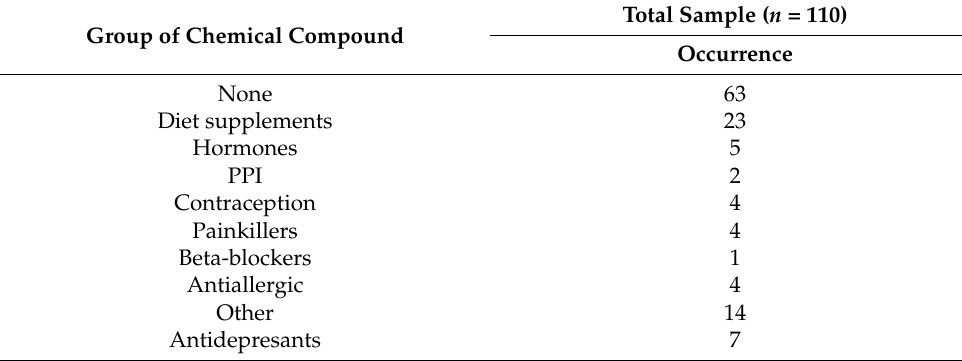
Table A1. Number of drugs taken by patients in the examined sample.